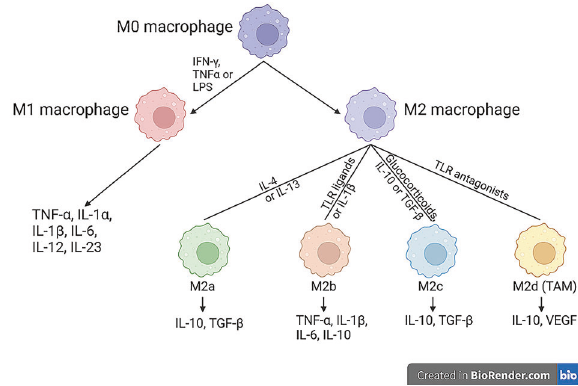
Fig. 3 Polarization and categories of macrophage. Macrophages can polarize into two main phenotypes, M1 and M2, when stimulated by different substances. M2 macrophages can be further divided into four subtypes (M2a, M2b, M2c and M2d) for their characteristic secretion and functions in certain